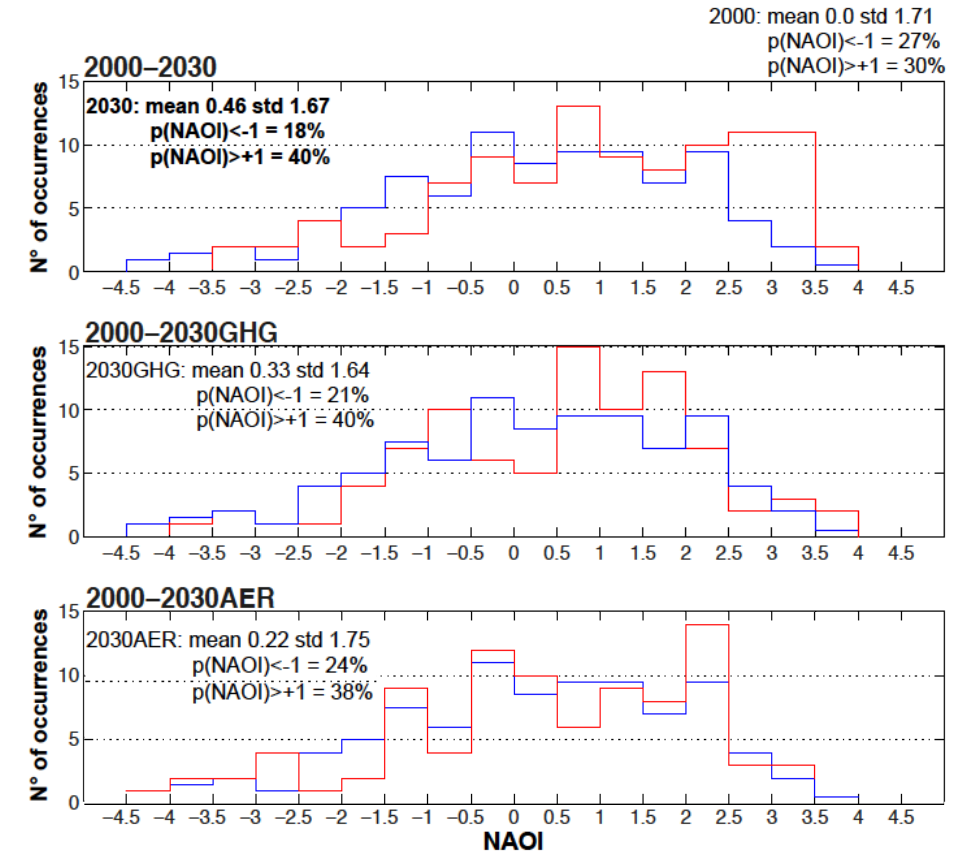
Figure 2. Frequency distributions of the winter (DJF) NAOI for the 2000 control simulation (blue, all panels), 2030 (red, upper panel), 2030GHG (red, central panel) and 2030AER (red, lower panel). Numbers show the NAOI mean value, the standard deviation (SD) and the probability of having a NAOI greater than + 1 ( p (NAOI)> + 1) or smaller than − 1 ( p (NAOI)< − 1). Values of the simulations having a NAOI mean significantly different from 2000 control mean at 95% confidence level are shown in bold. The 2000s mean NAO is by definition equal to 0 and the number of occurrences has been normalized to 30 years for a direct comparison with the other simulations. Table 3. PM relative anomalies (unitless) associated to different percentiles for the WM and CE regions in the 2000 experiment (first and third rows) and their relative changes (in %) for the 2030 simulation compared to 2000 values (second and fourth rows). Region Experiment Percentile 5th 25th 50th 75th 95th Western Mediterranean 2000 0.49 0.73 1.01 1.25 1.57 2030 + 8% + 1% − 9% − 7% + 4% Central Europe 2000 0.65 0.80 0.94 1.13 1.48 2030 − 14% − 3% + 2% + 2% +